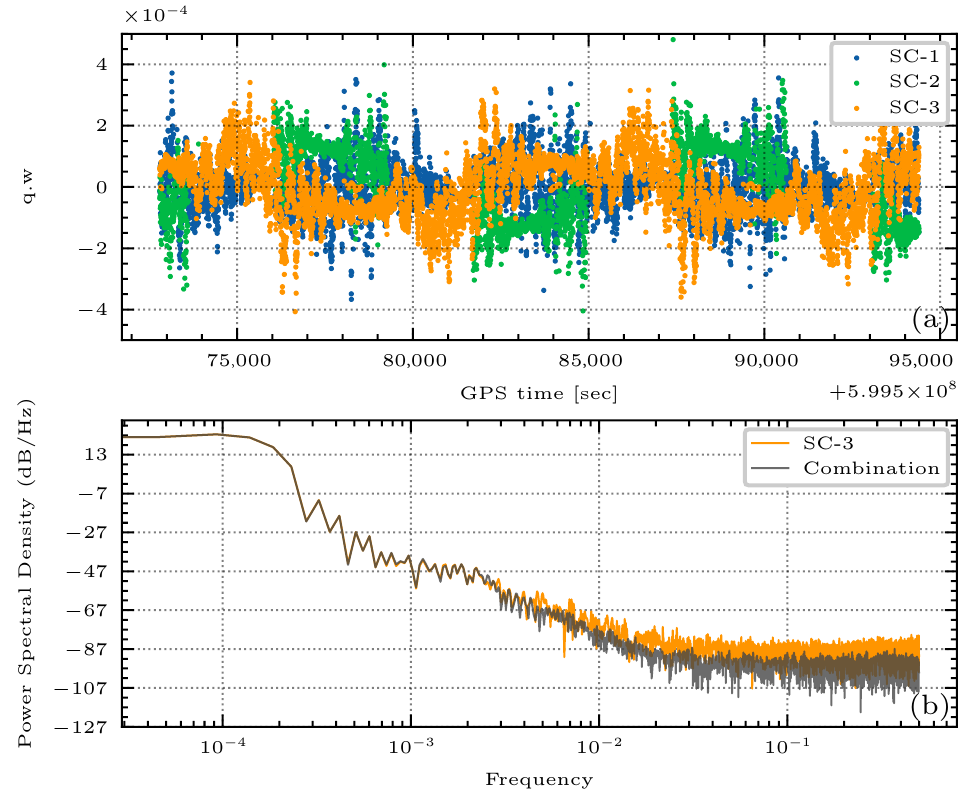
Figure 5. ( a ) Misalignment between three SCs and ( b ) their comparisons with the combination result on 6 December 2018 for GRACE-FO Sat-C. All are performed in terms of quaternion component q . w as an